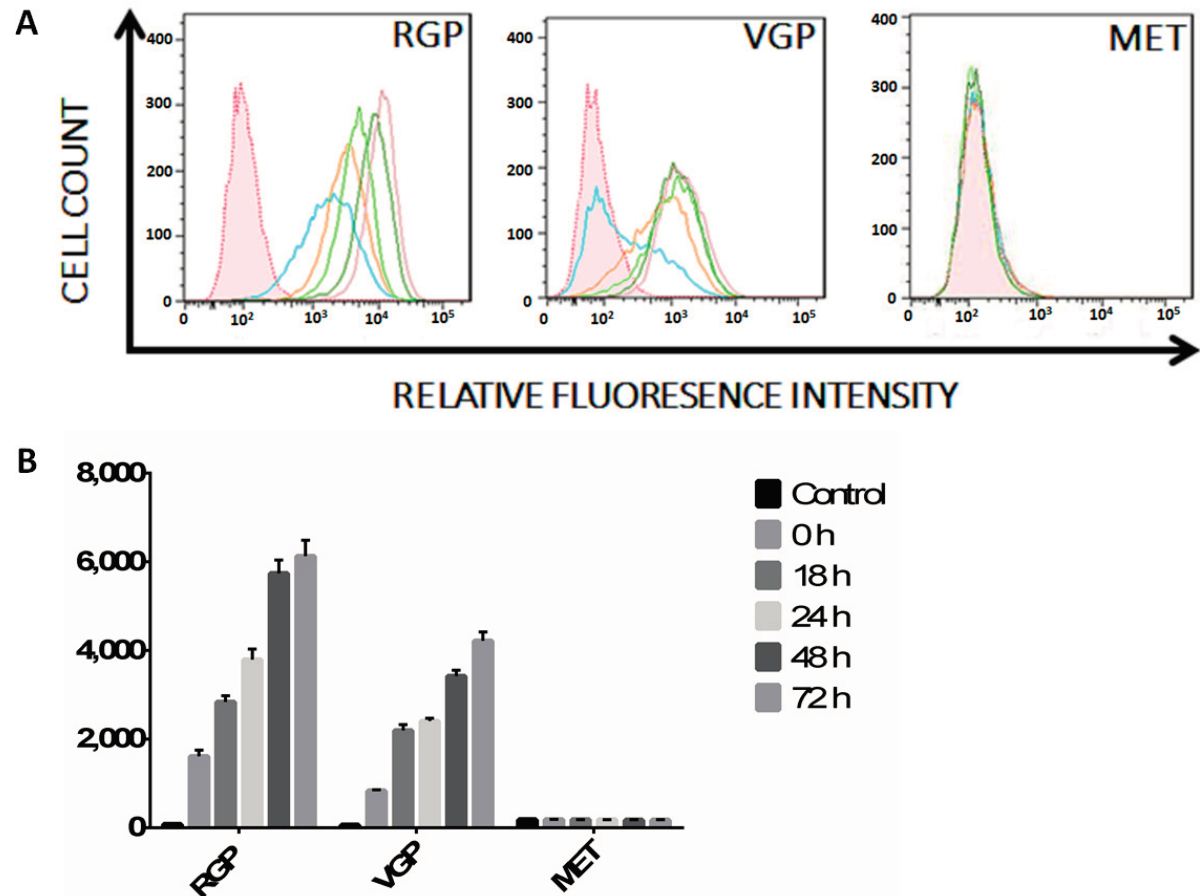
Figure 2. Flow cytometric analysis of MHC II cell surface expression in RGP, VGP and MET cells. ( A ) Cells were treated with IFN- γ for 0 h (blue), 18 h (orange), 24 h (lime green), 48 h (dark green) or 72 h (mauve). Unstained cells (shaded histogram) are shown as a